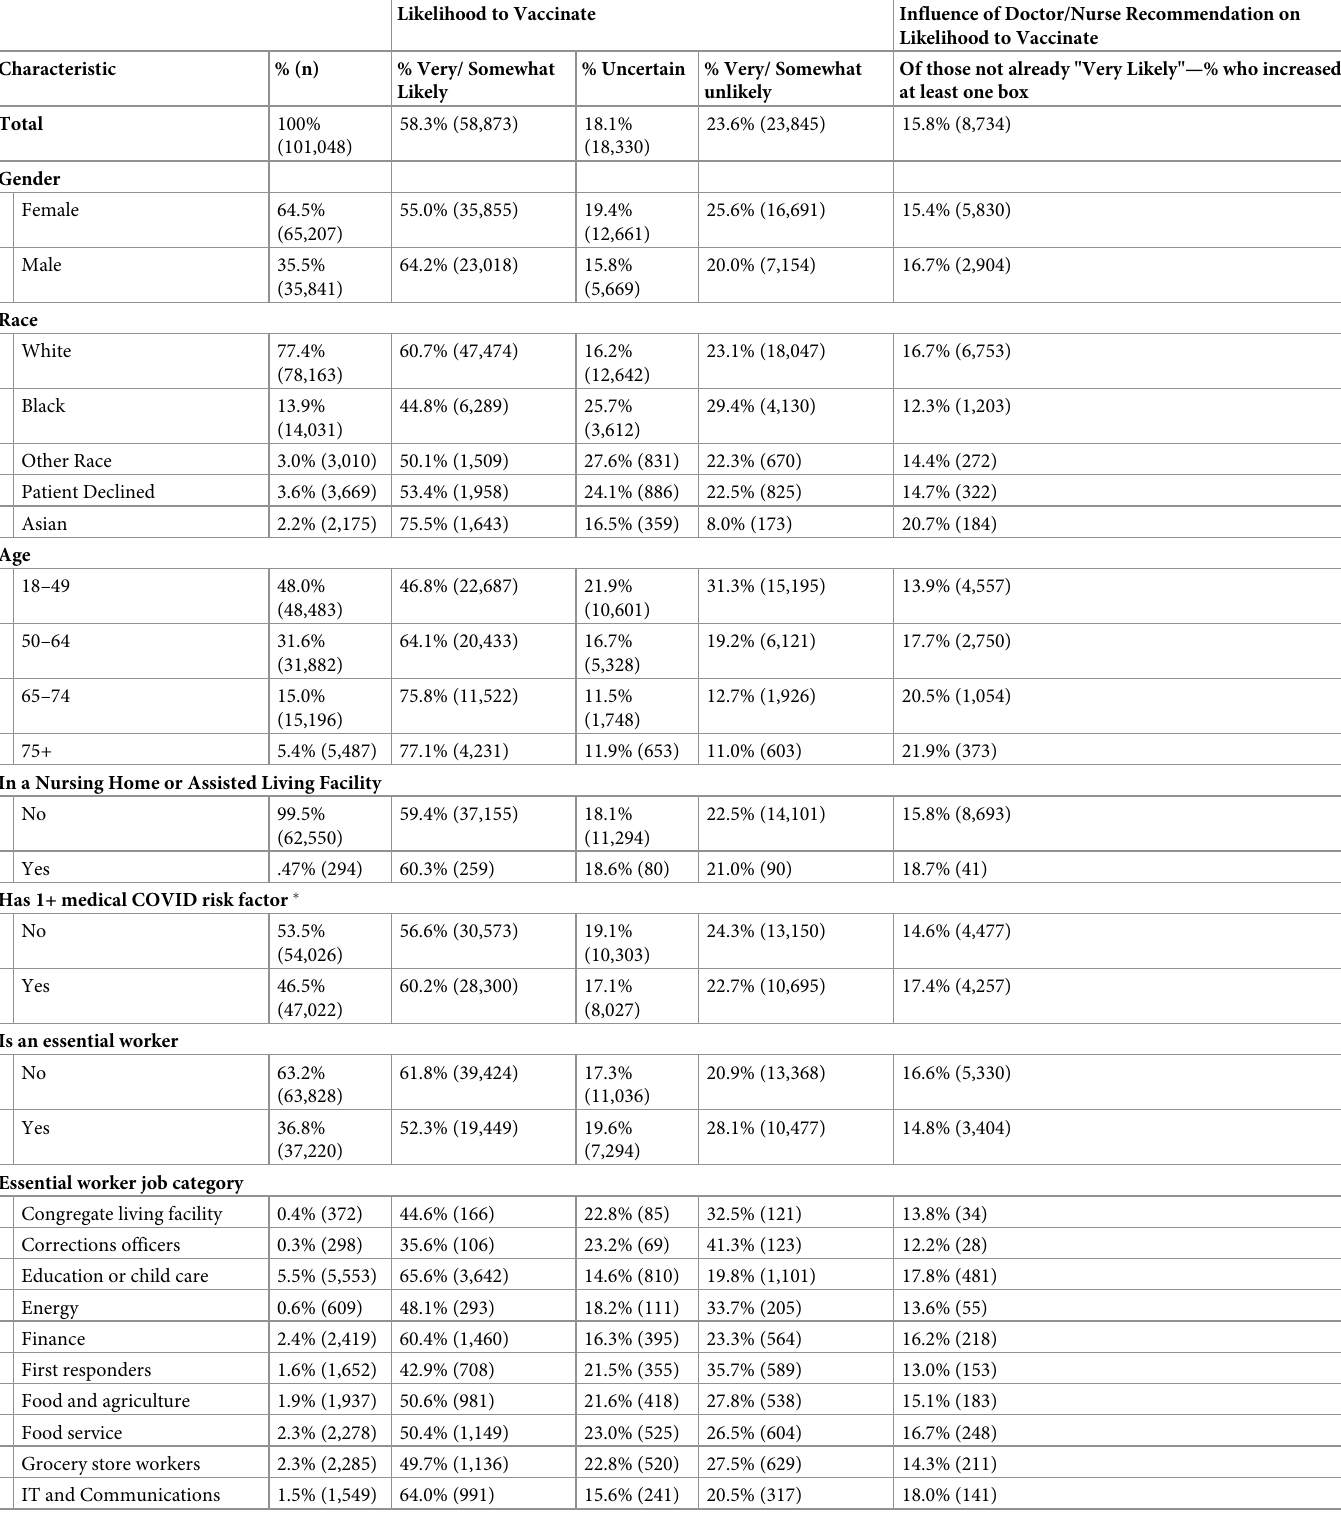
Table 1. Demographic representation of survey respondents who indicated they had not yet received a COVID-19 vaccine. Likelihood to